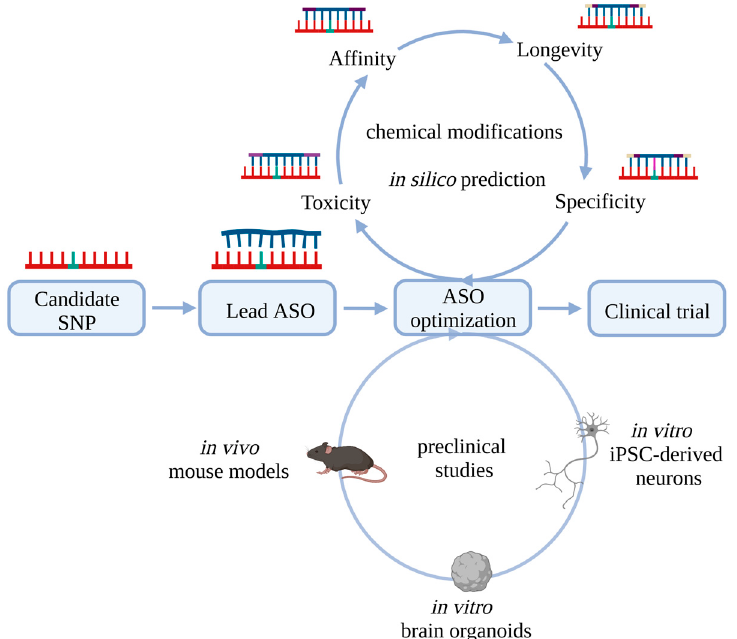
Figure 4. Workflow of in vitro testing and optimization of allele-specific ASOs. For allele-specific testing of ASOs, the association of the target with the mutation and the distribution in the population and patients should be known or determined. One or more lead ASOs could be tested at different positions, giving a first indication of the targetability of the (pre-)mRNA position. In further in vitro experiments, the lead ASO can be further modified to decrease toxicity and increase longevity, affinity, and allele-specificity. Different model systems have different advantages regarding evaluation of ASOs. IPSC-derived 2D models are a fast and cost-efficient tool to test the effectiveness of an ASO in a model with the genotype of a patient. Nevertheless, more complex systems, such as brain organoids, provide more precise information about the effects on the pathomechanism, such as aggregate formation, but also provide the opportunity to investigate off-targets in several neural cell types in parallel. Mice are still the model of choice to investigate (acute) toxicity and specificity in an in vivo system .